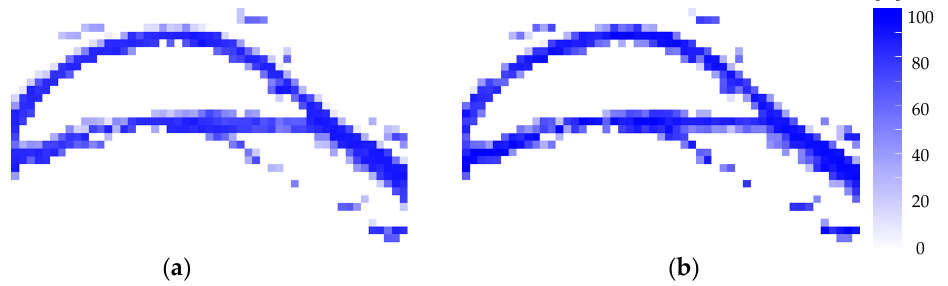
Figure 14. Water fractions of the WV-3 image obtained from ( a ) the proposed OBA-NDWI method and ( b ) the SPU algorithm.